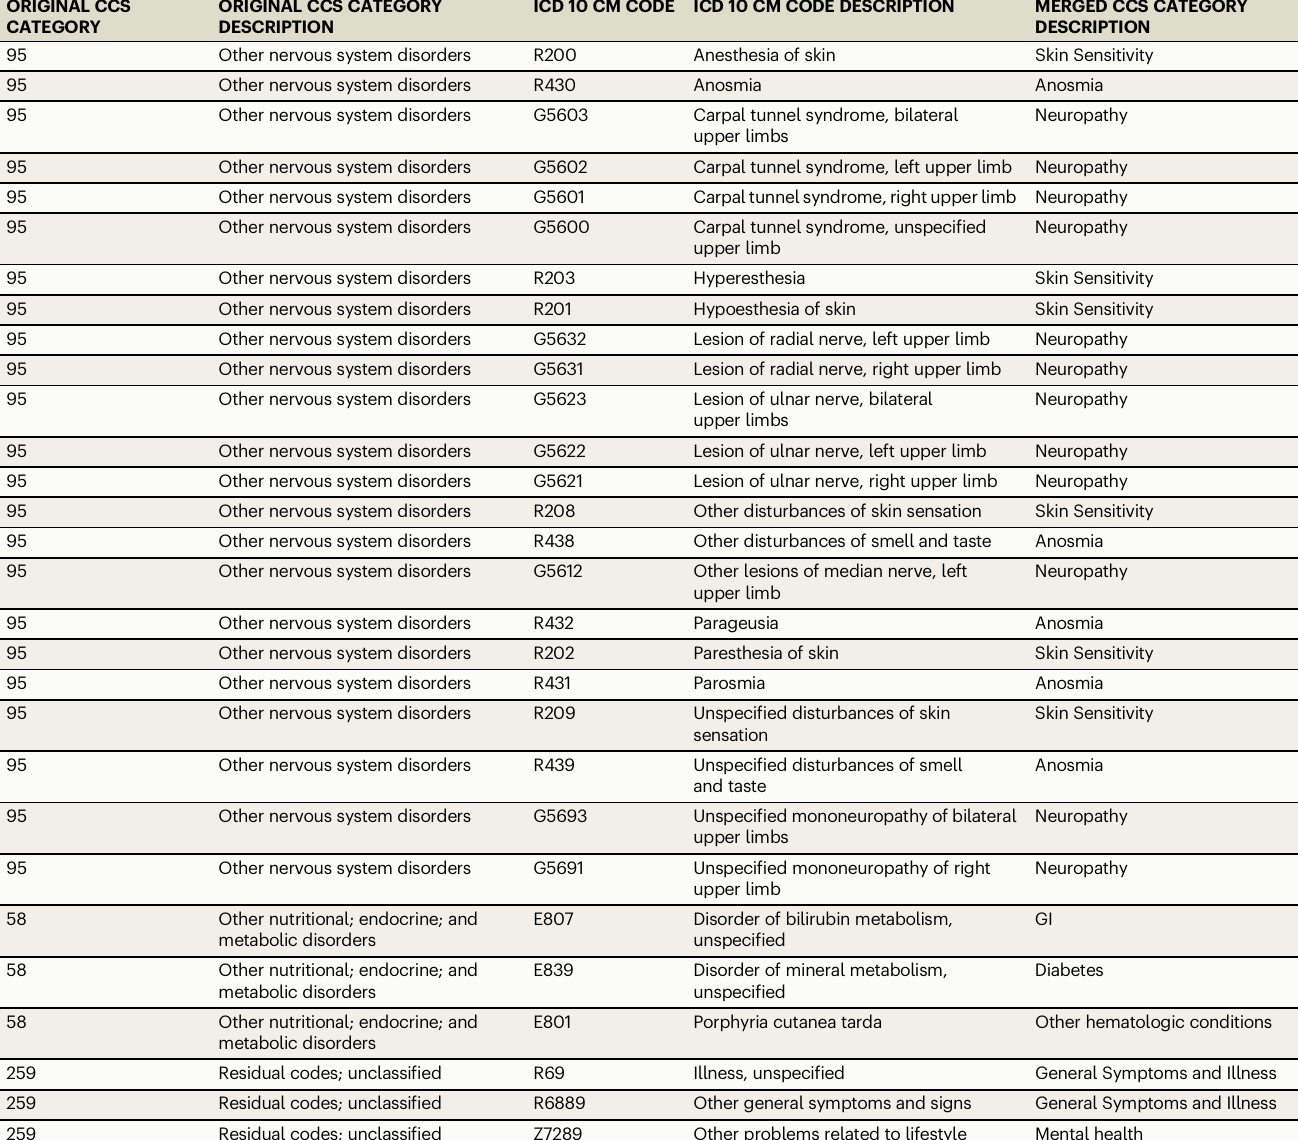
Table 8 | Speci fi c ICD diagnoses merged in analysis ORIGINAL CCS